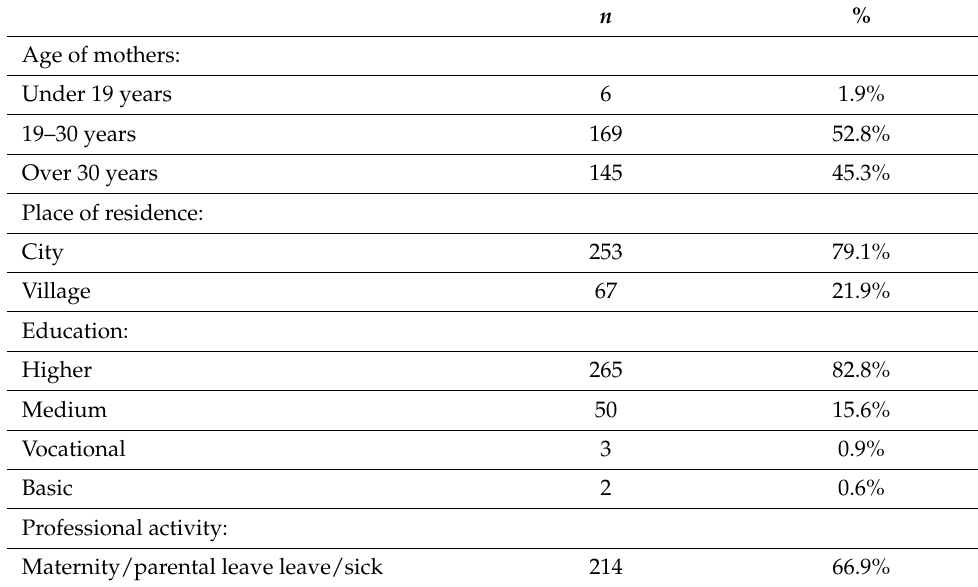
Table 1. Characteristics of the study group of